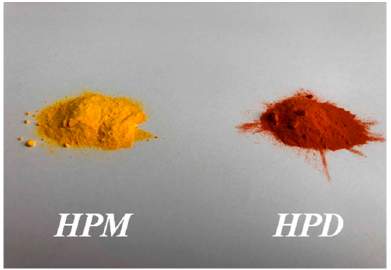
Figure 2. Digital photos of prepared hybrid pigments.